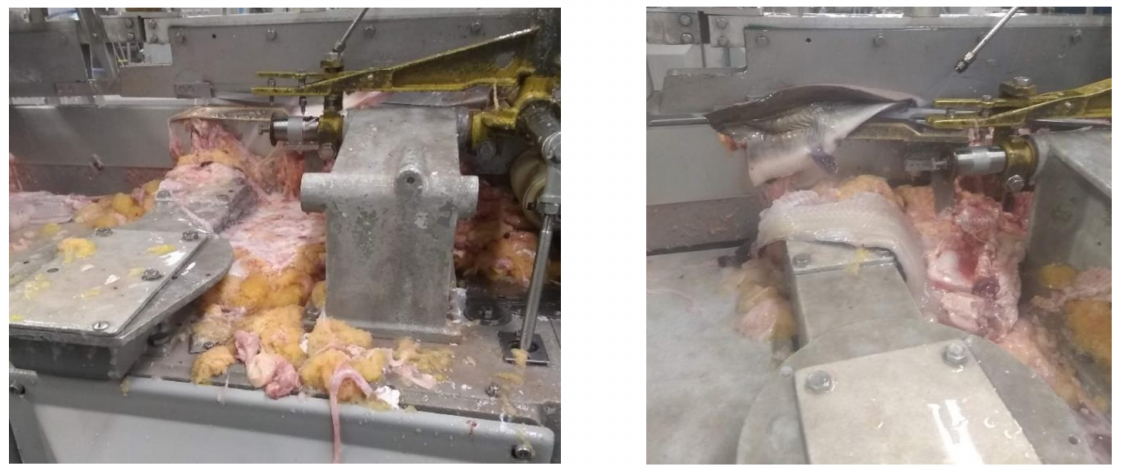
Figure 3. The filleting machine is frequently jammed because the fish guts are left in the machine. The normal filleting processing is affected by the jamming issue, which makes some fillets drop out of the machine as waste.